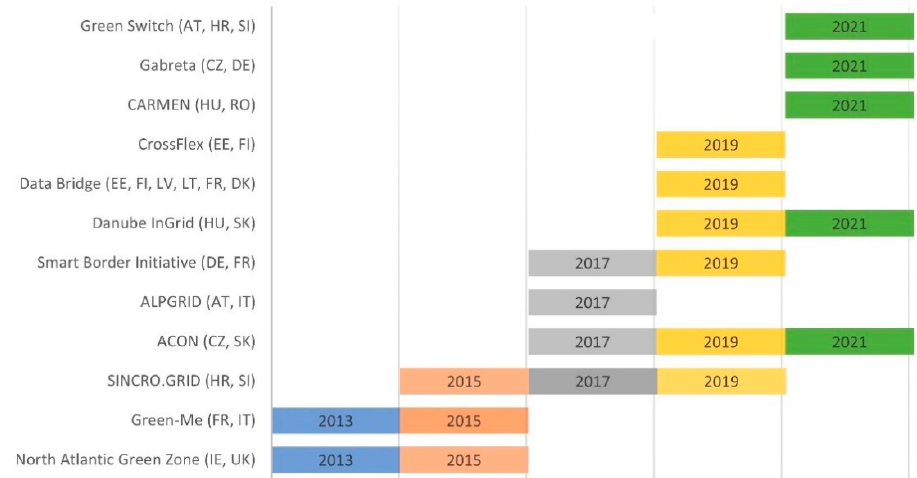
Figure 1. Smart grid projects of common interest in the PCI list between 2013–2021.